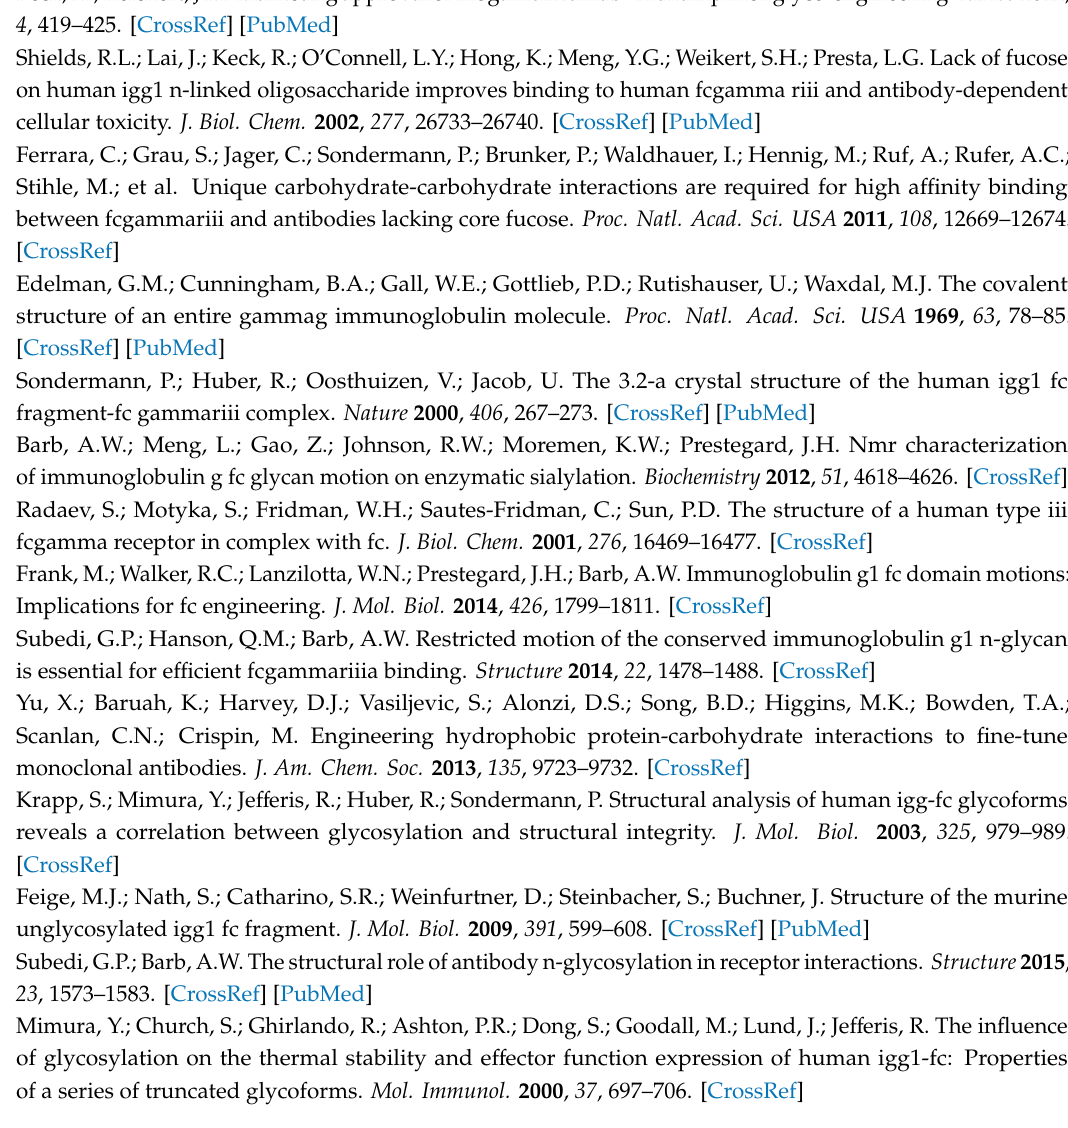
Figure S1: Reduction in H / DX (%) of trastuzumab glycan variant peptides (whole sequence) ; Figure S2: Uptake di ff erence plot with D uptake (Da) of alternatively linked trastuzumab sialylation variants (light chain only); Figure S3: Volcano plot showing statistical significance testing of trastuzumab ST3 and ST6 D uptake di ff erences; Table S1: D uptake di ff erences and reduction in H / DX values; Table S2: Relative Fc γ R binding of trastuzumab glycan variants; Table S3: D uptake di ff erences of trastuzumab G2S2F ST3 versus